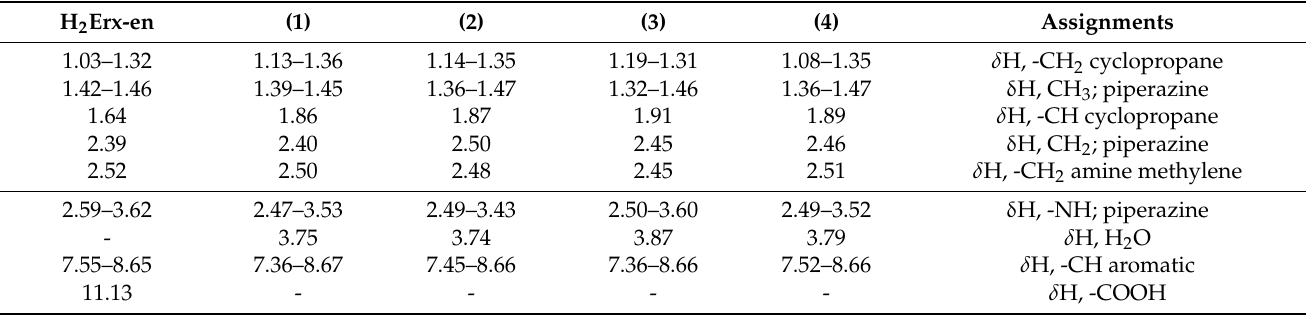
Table 4. 1 H NMR values (ppm) and tentative assignments for H 2 Erx-en and its metal